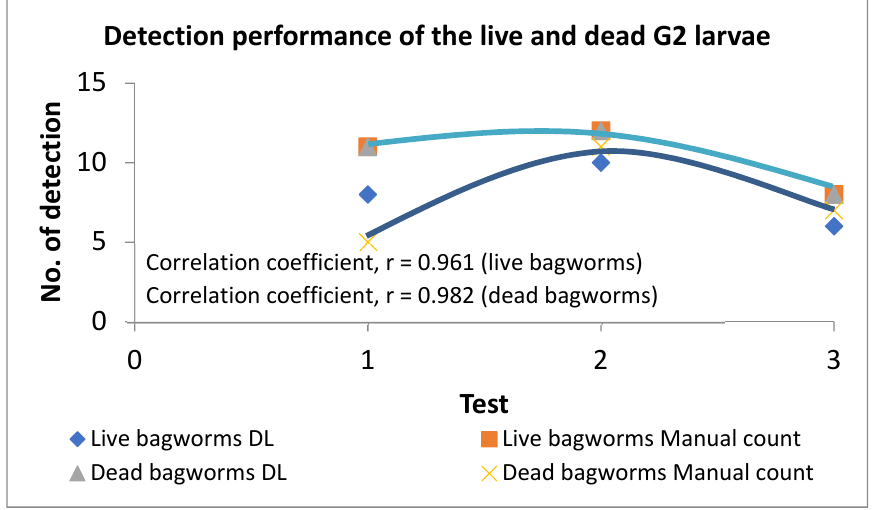
Figure 17. Detection performance of the live and dead G2 larvae by deep learning (DL) and manual counting.